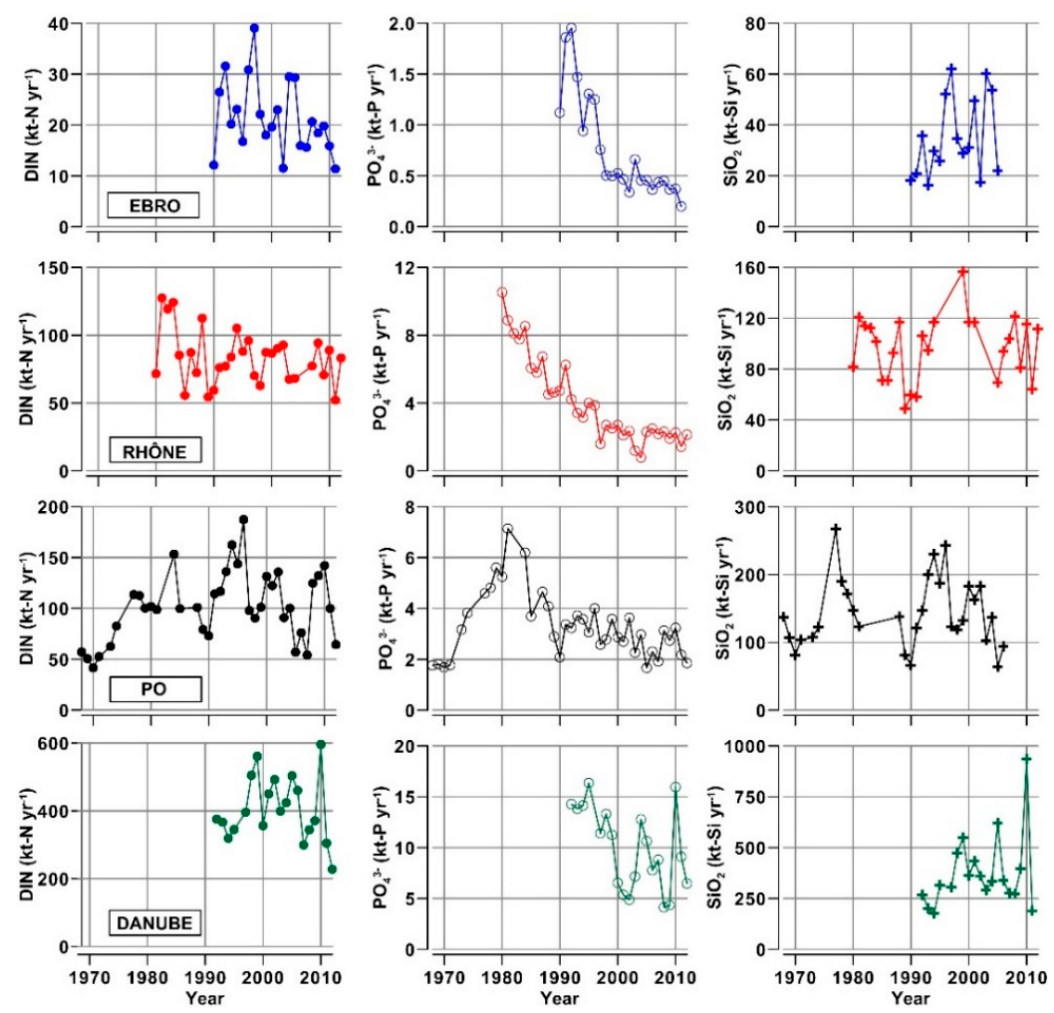
Figure 4. Time series of annual transport (kt yr − 1 ) of the main nutrients (DIN, PO 43 − and SiO 2 ) in the four considered rivers.